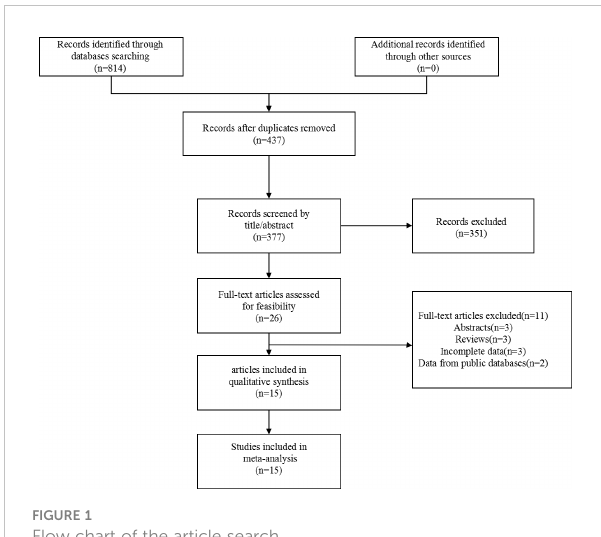
FIGURE 1 Flow chart of the article